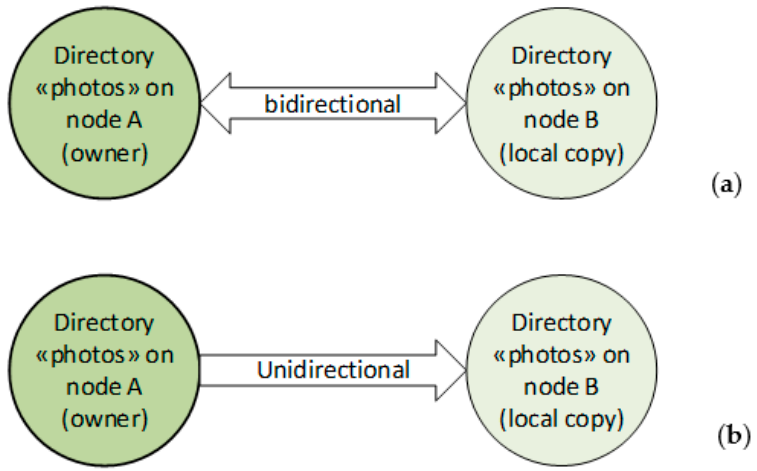
Figure 1. Bilateral synchronizations: ( a ) bidirectional and ( b ) unidirectional.